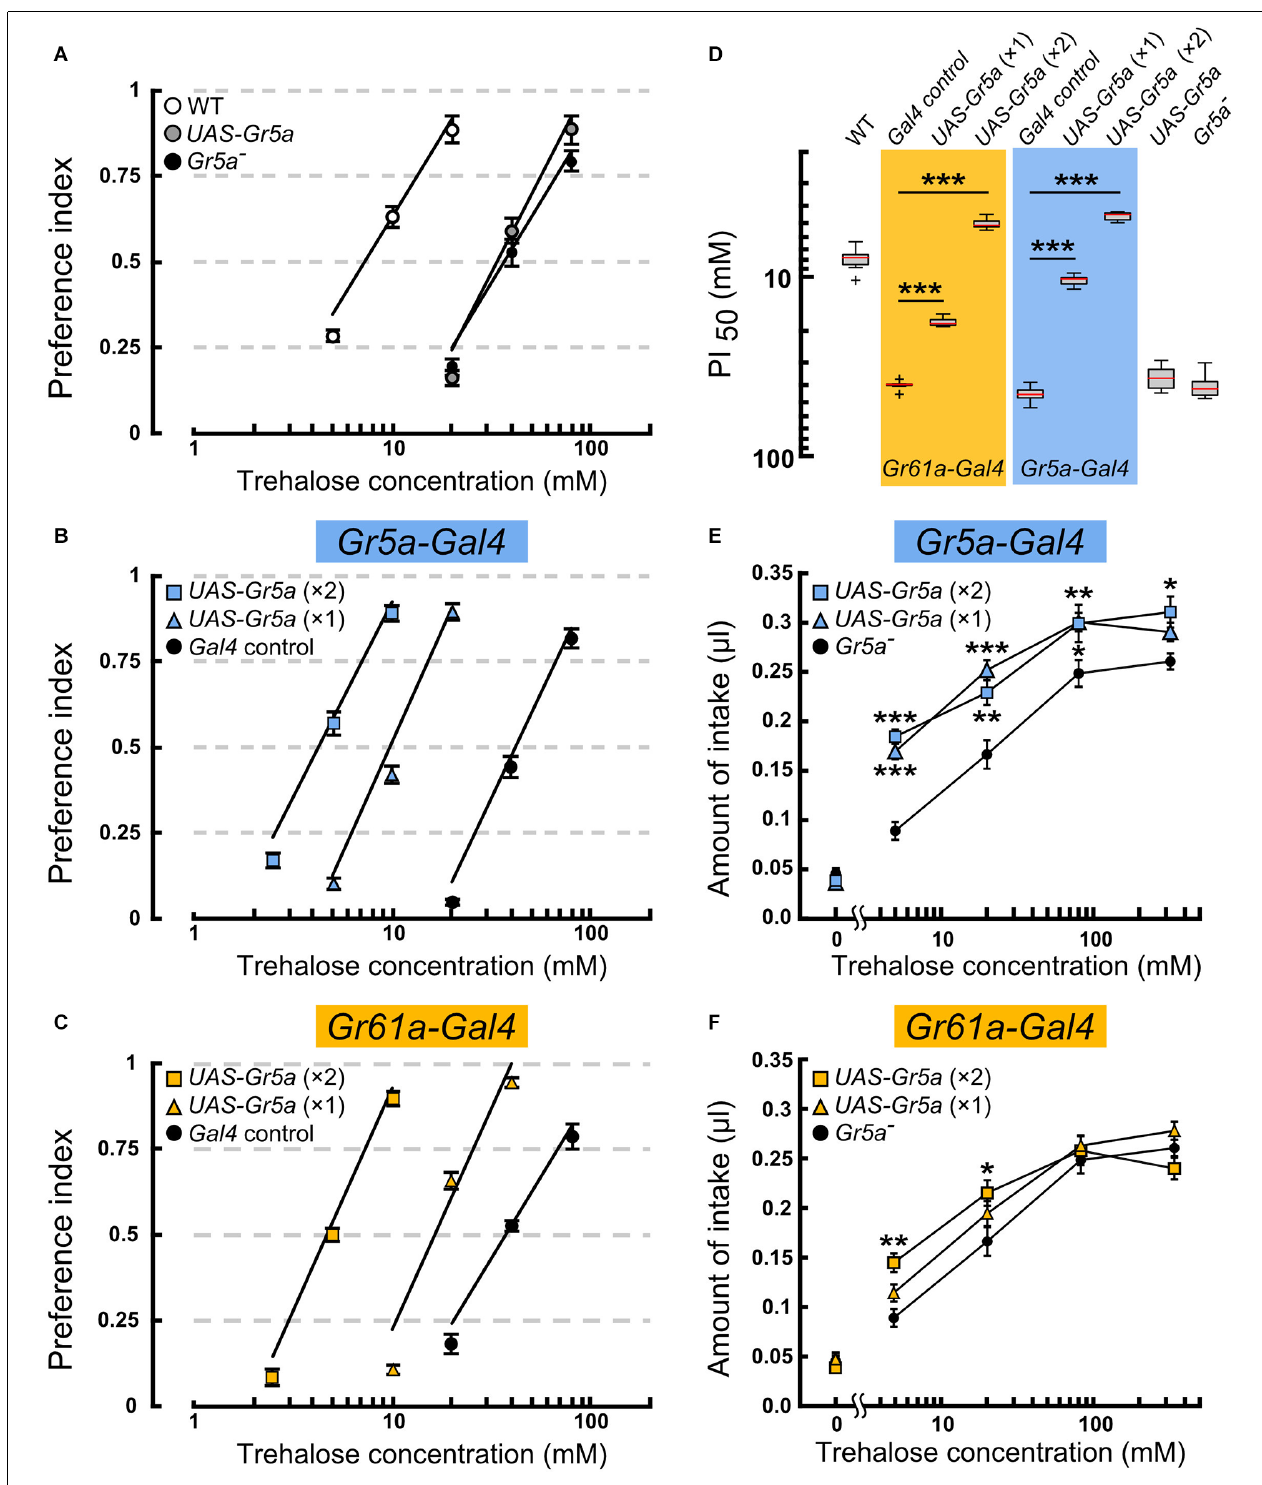
FIGURE 2 | Overexpression of the Gr5a + transgene targeted to Gr5a + or Gr61a + GRNs in Gr5a − flies differentially modulate ssugar preference and intake. (A–C) Feeding preference for various concentrations of trehalose as determined by the two-choice preference test using 2 mM sucrose as a reference. *** p < 0.001 by Welch’s t -test with Bonferroni correction ( n = 7–9 experiments). (D) The concentrations of trehalose solution at which trehalose was equally preferred to 2 mM sucrose solution. (E,F) Concentration dependence of trehalose intake in flies with Gr5a + transgene expression as driven by Gr61a-Gal4 (E) or Gr5a-Gal4 (F) . * p < 0.05, ** p < 0.01, *** p < 0.001 by Student’s t -test ( n = 7–9